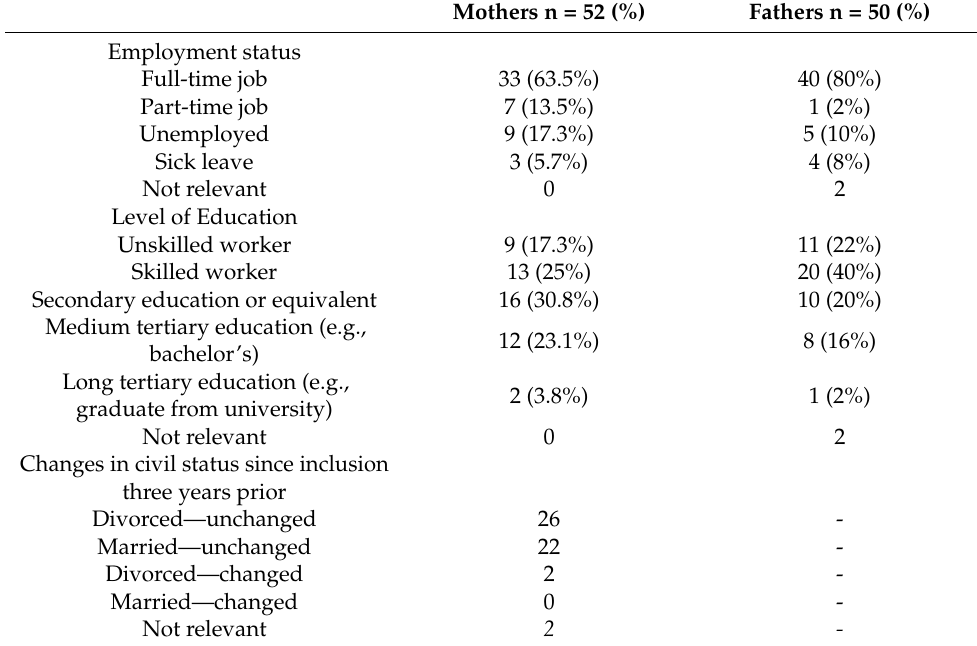
Table 1. Parental demographics and civil